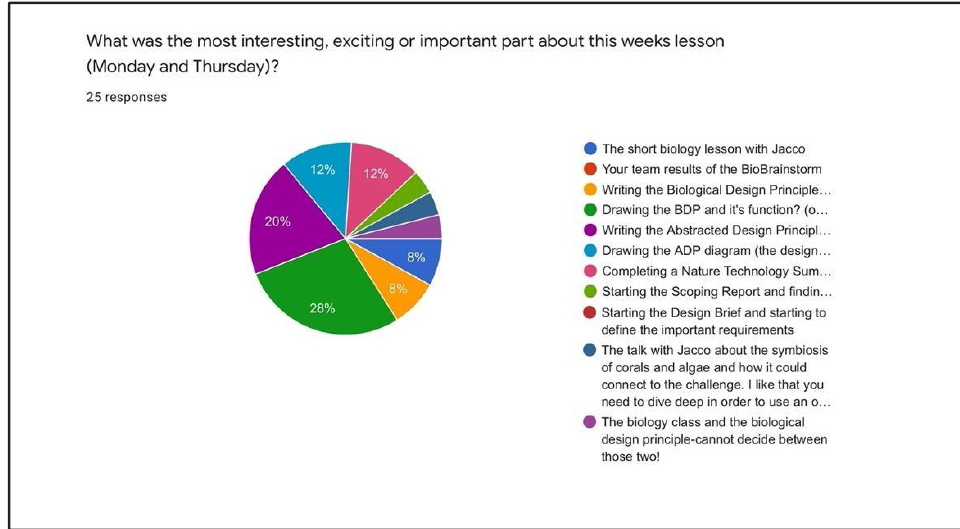
Figure 7. Student cohort of 2022 responses to “most important” exercise. (small section pie 4% each).